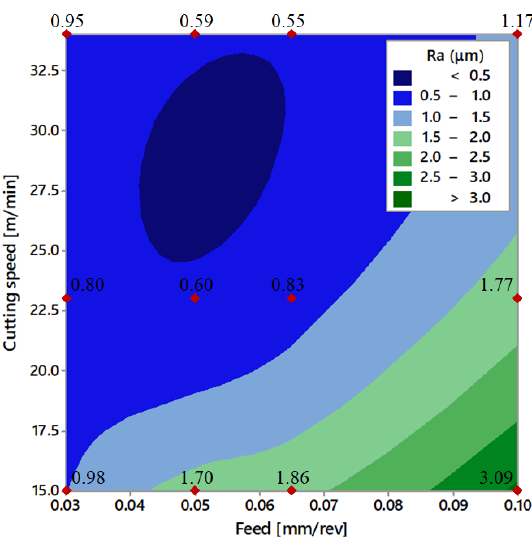
Figure 5. Contour plot of surface roughness against cutting speed and feed, with experimental data. Red points refer to the roughness experimental data.